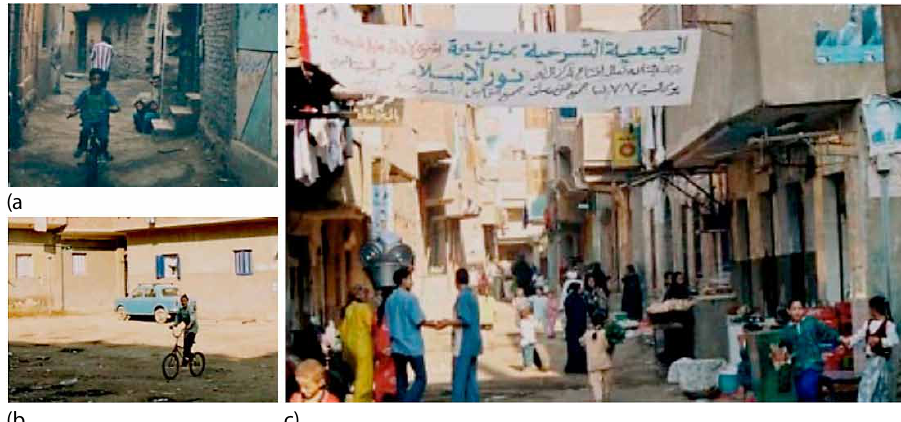
fig. 5 a, b, c: Children in the Manial Sheha appropriate open spaces as